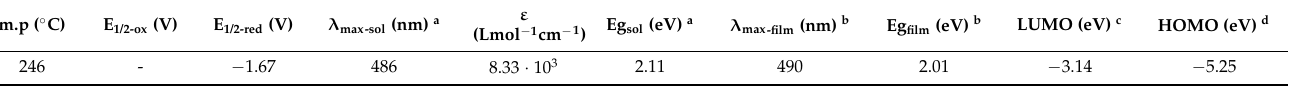
a Optical band gap estimated from the low-energy band edge in the optical spectrum. Concentrations are 10 − 4 –10 − 5 M in CHCl 3 ; b Optical bandgap estimated from absorption onset (Eg = 1240/ λ onset ) of spin- cast film from 5 mg/mL of CHCl 3 solution on glass substrates; c E LUMO = [ − (E red − E 1/2-ferrocene ) +